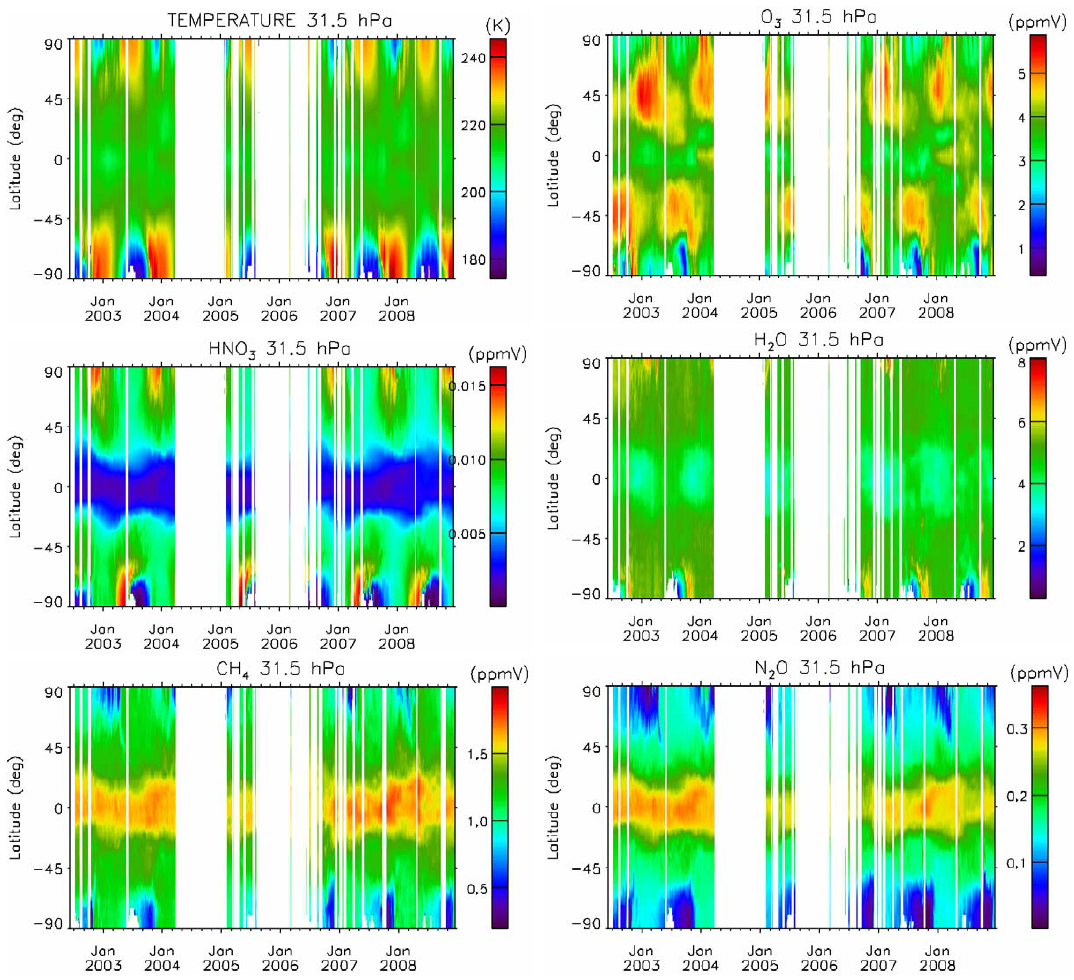
Fig. 10. 5-days means of temperature, ozone, HNO 3 , water, methane and N 2 O, mapped as a function of time and Latitude for the pressure level of 31.5hPa